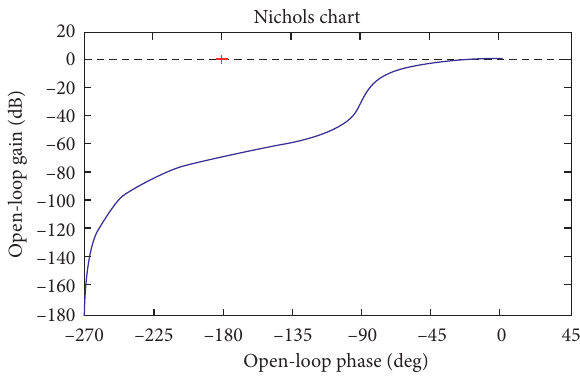
Figure 7: The Nichols plot.